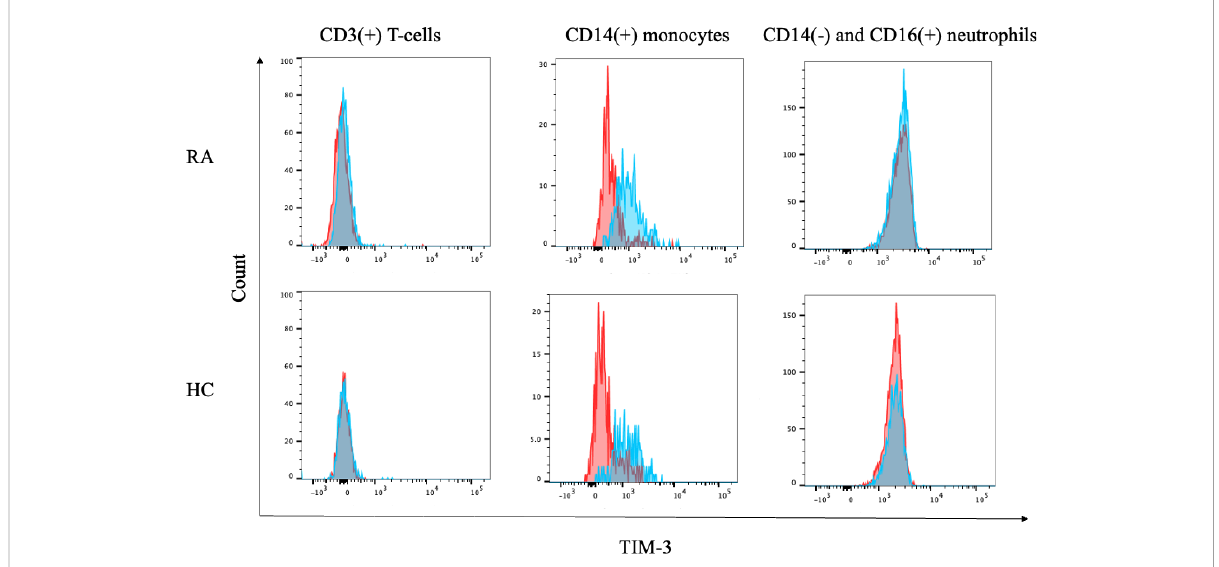
FIGURE 6 Expression of TIM – 3 on blood cells. Flow cytometry overlay histograms for TIM – 3 demonstrating typical cell pro fi les from subdivided peripheral blood cells from RA patients and HC. TIM – 3 expression was detected using anti-TIM – 3 antibody (blue shaded histogram) or isotype control antibody (red shaded histograms). In contrast to lymphocytes or neutrophils, peripheral blood monocytes expressed CEACAM1 on their surface. RA, rheumatoid arthritis.